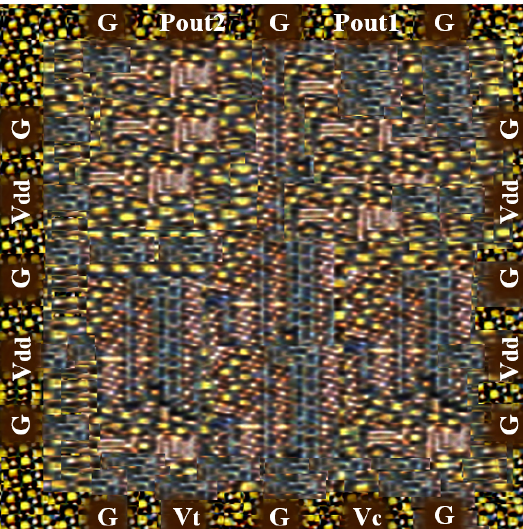
Figure 17. Layout of the proposed VCO.